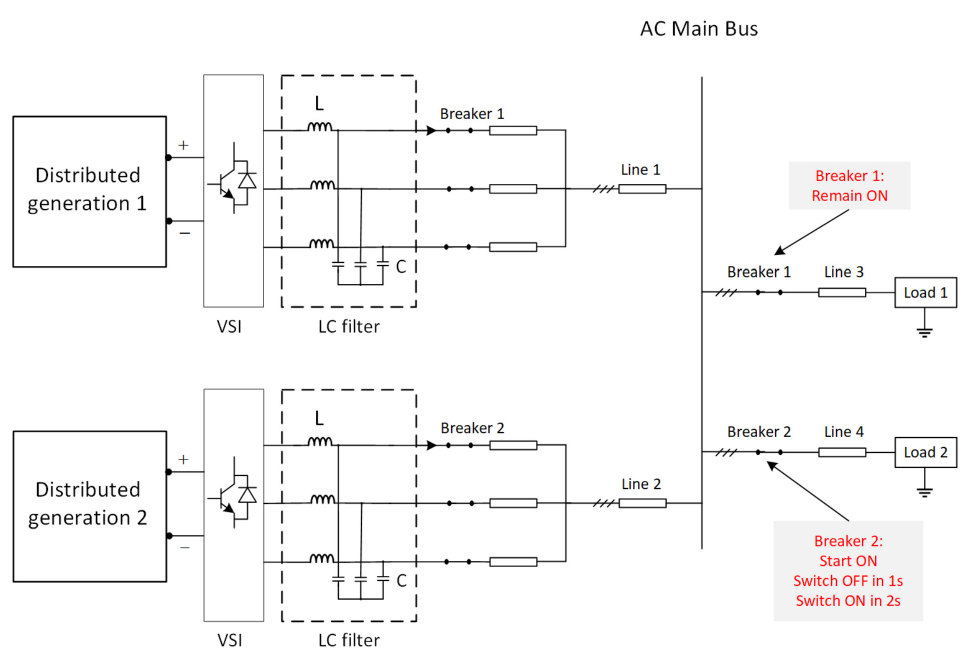
Figure 6. Second-order system in simulation.